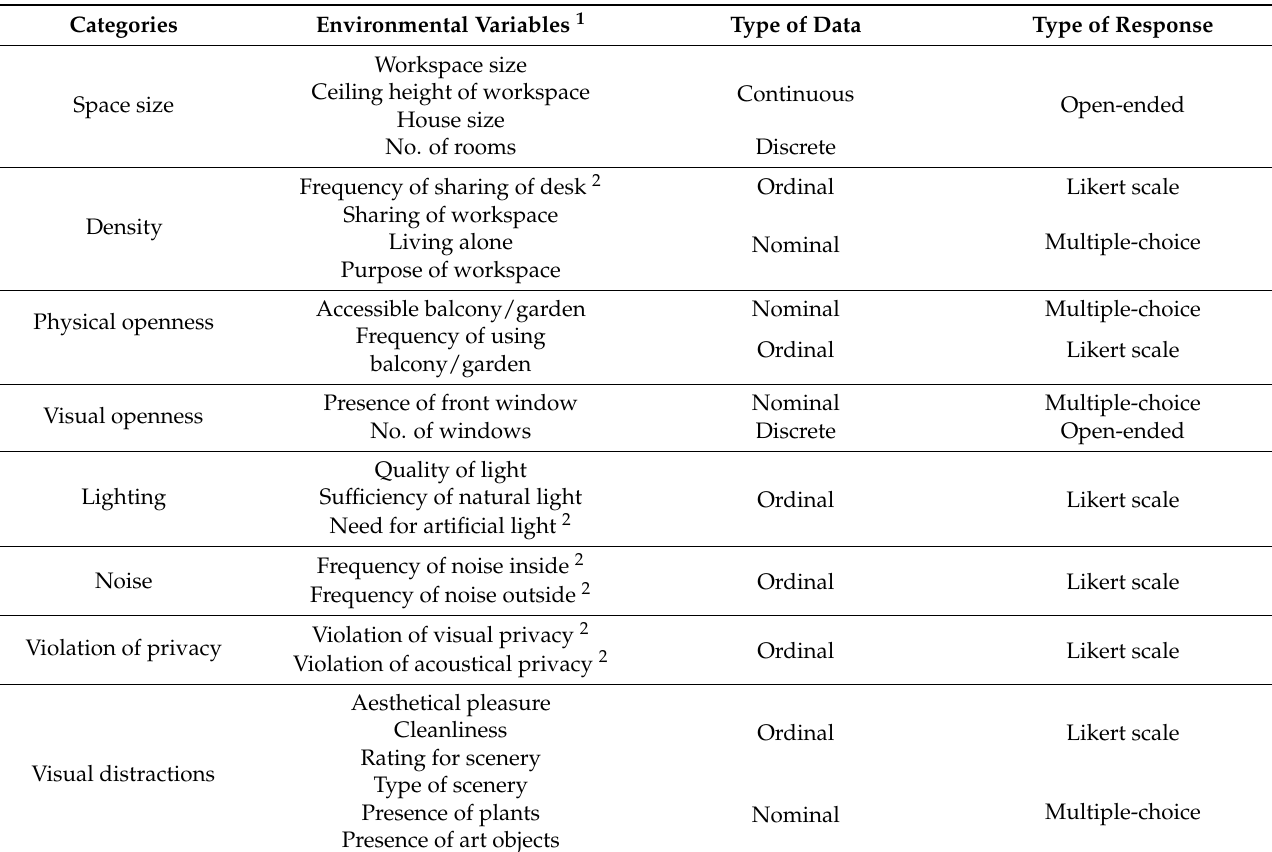
Table 1. Variables of features of home